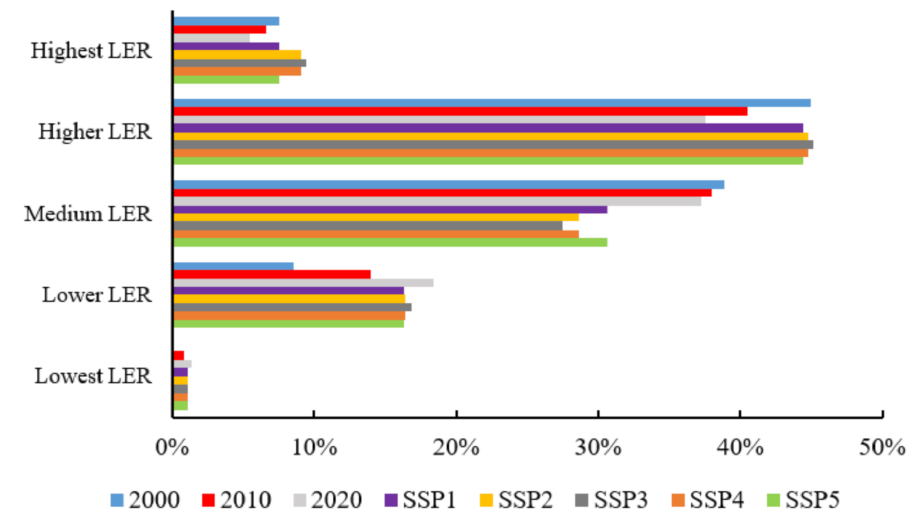
Figure 3. Percentage of each landscape ecological risk level during 2000 to 2030.